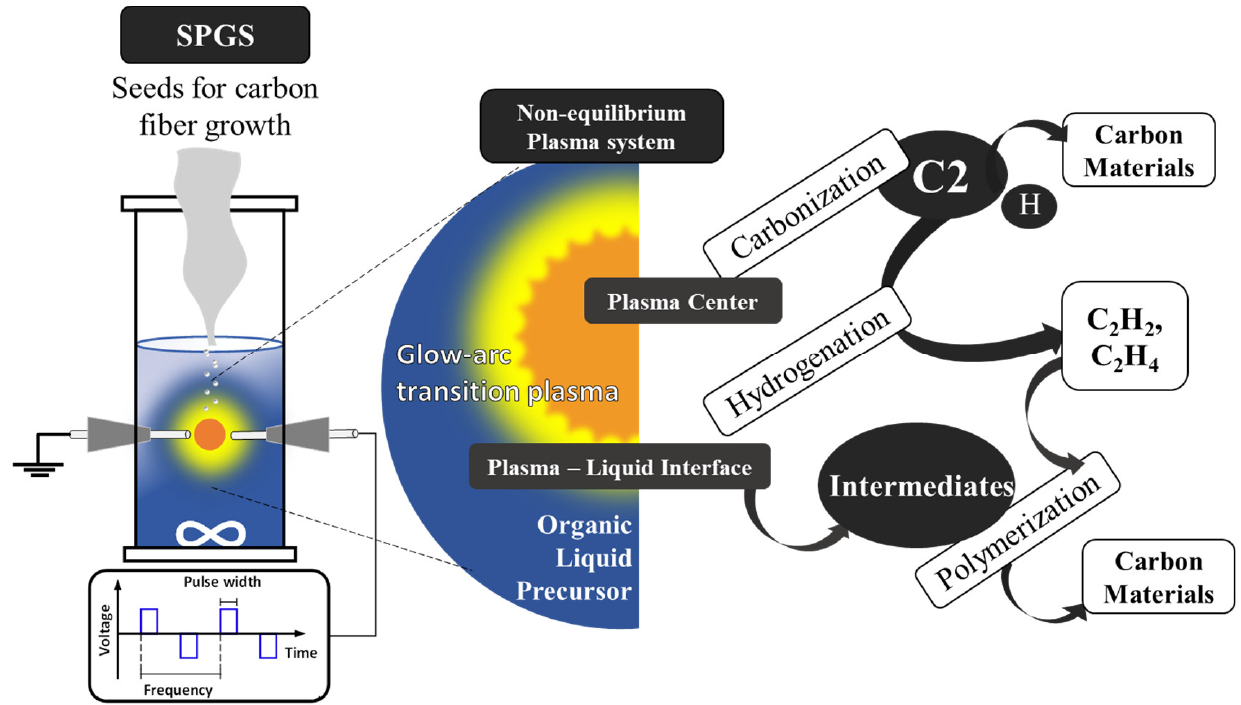
Figure 1. Concept for the utilization of SPGS for carbon fiber growth.